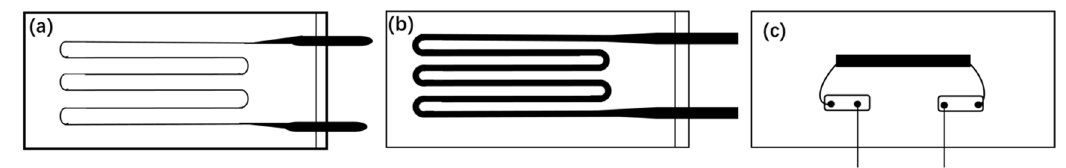
Figure 2. Typical structures of sensitive grid wires in a resistance strain gauge. ( a ) Paper-based wire strain gauge, ( b ) polyimide-based grid strain gauge, and ( c ) semiconductor strain gauge.